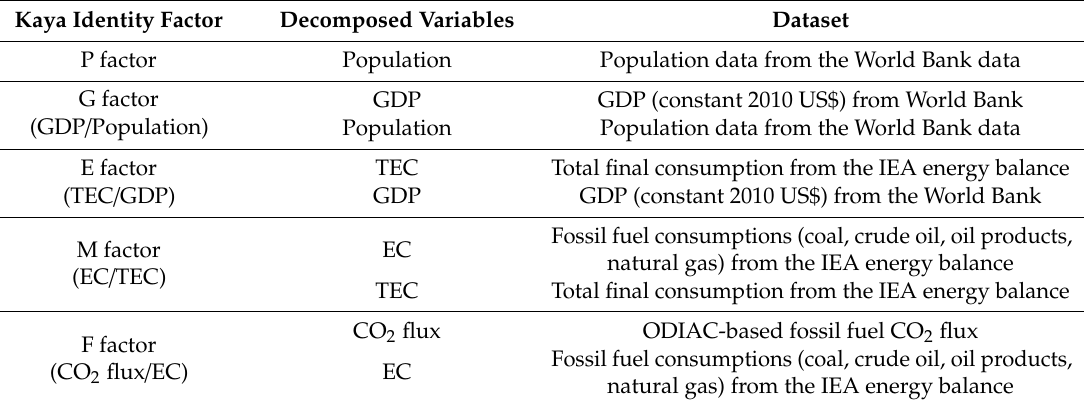
Table A1. Descriptions of datasets applied in calculating Kaya identity